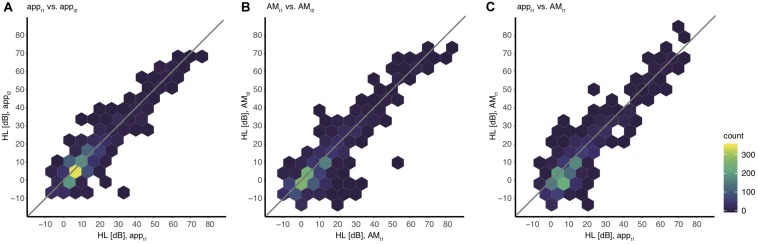
Association between hearing levels within and between devices including all values. The color indicates the absolute number of thresholds for all individual ears and all frequencies. Note that single outliers (one ear, one frequency) can appear already as a dark blue hexagon. (A) appt1 vs. appt2, (B) AMt1 vs. AMt2, (C) appt1 vs. AMt1.